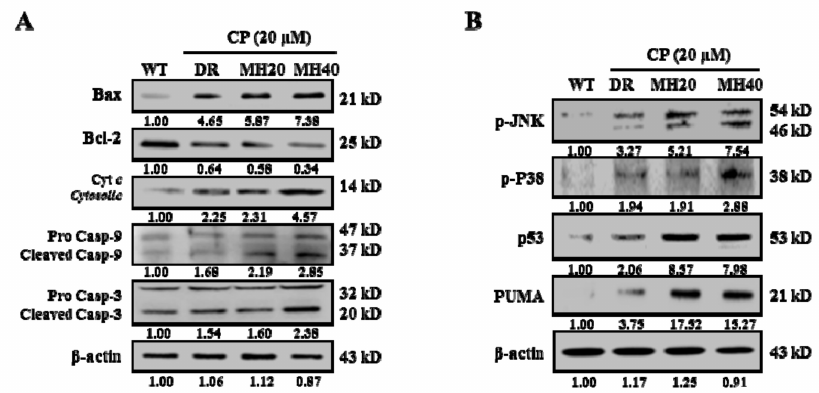
Figure 6. MH regulated the ratio of Bcl-2 / Bax and the activation of p38 / JNK stress activated protein kinase. ( A ) Expression levels of major pro-apoptotic and anti-apoptotic markers (Bax, Bcl-2, Cyt c, procaspase-9 / cleaved caspase-9, and procaspase-3 / cleaved caspase-3) were measured in cytosolic and mitochondrial fractions of HepG2 WT and HepG2 DR cells by Western blotting; β -actin was used